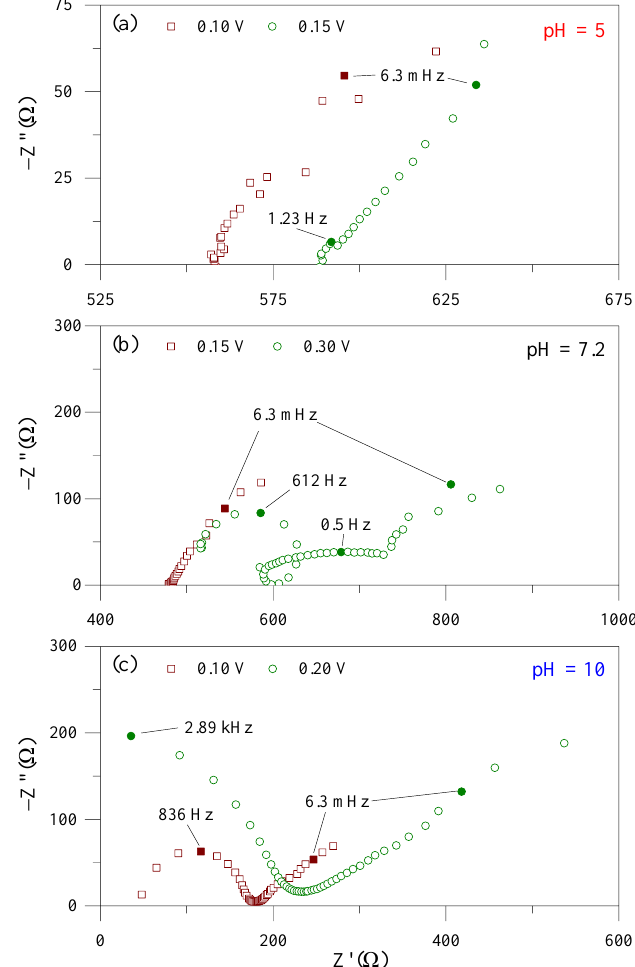
Figure 4. Electrochemical impedance spectroscopy spectra for the 0.001 M H x PO 43 − x solution at ( a ) pH 5, ( b ) pH 7, and ( c ) pH 10. The impedances were obtained at bias potentials comprehending i < i lim,1 (red) and i = i lim,1 (green) region of the polarization curve. Solid points refer to characteristic frequencies.